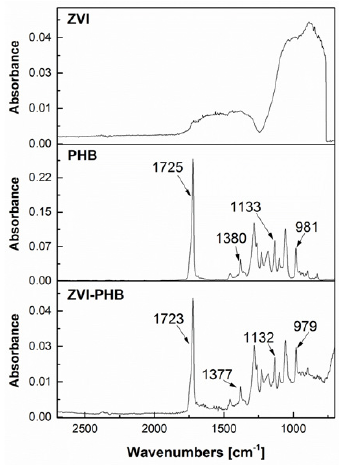
Figure 2. Fourier transform infrared spectroscopy (FTIR) measurements of bare ZVI, thermally treated PHB, and ZVI–PHB composite (ZVI/PHB ratio 1:2 w / w ).